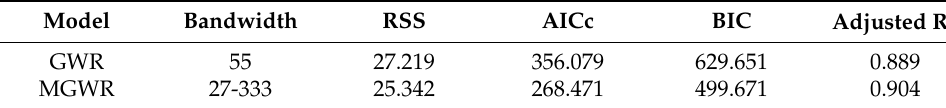
Table 4. Comparison of model superiority in GWR and MGWR.